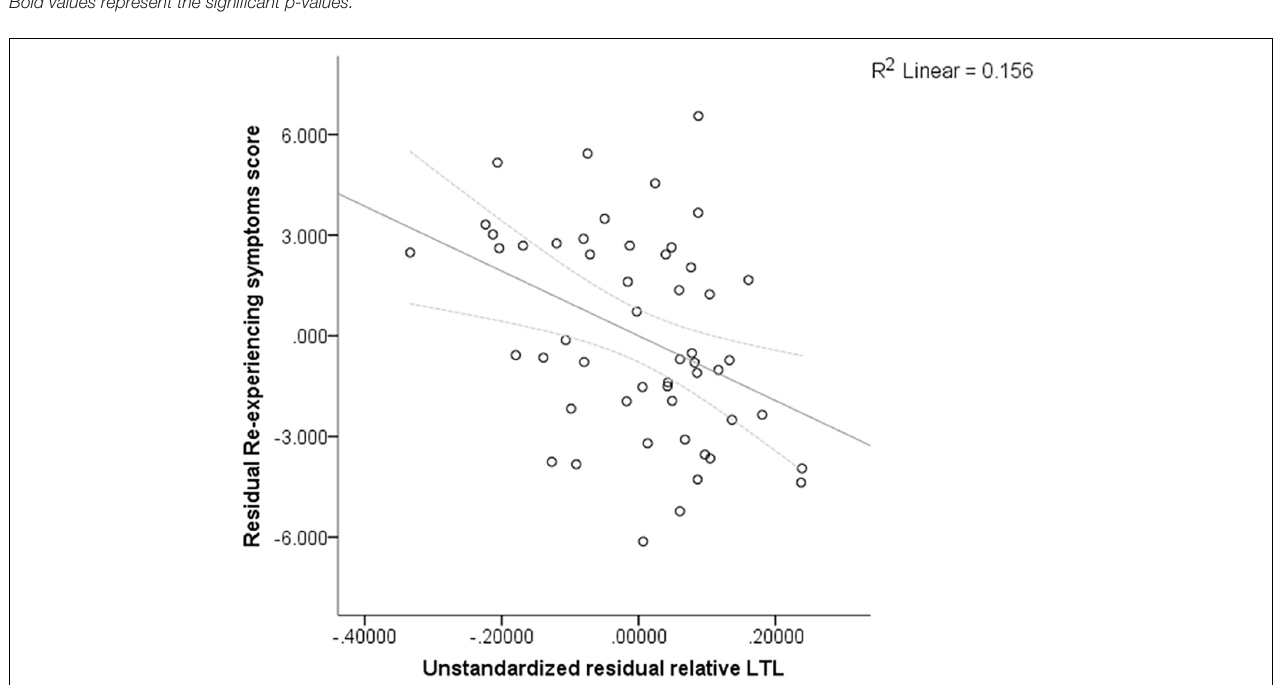
FIGURE 2 | Partial regression plot for the linear regression adjusted by per-person income reflecting the correlation coefficient between PTSD re-experiencing symptoms and relative LTL adjusted by